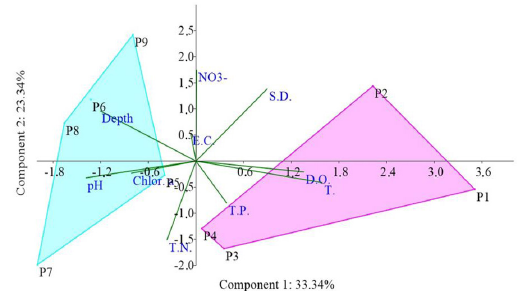
Figure 4. Principal Component Analysis (PCA) formed by axes 1 and 2 from correlation of limnological variables in surface waters of 9 collection points in the Broa reservoir.